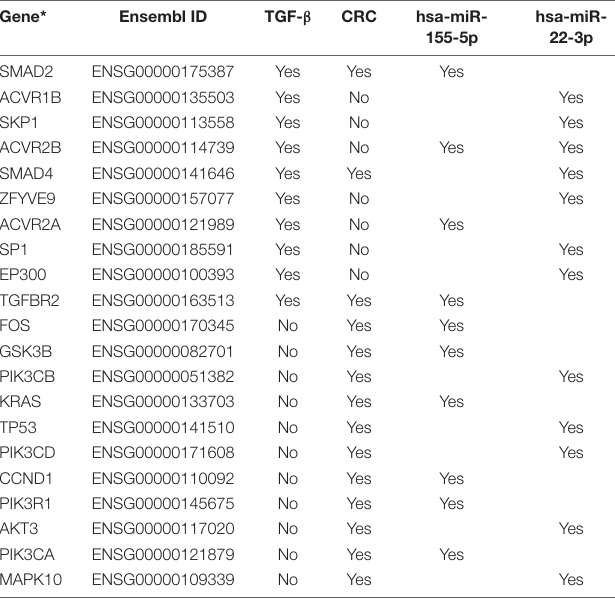
*MiRNA associated with microsatellite instability status, somatic tumor mutation burden, PD-L1 expression, M1 macrophage polarization that interact with the TGF- β signaling pathway (p = 0.008) and CRC pathways (p = 0.0001). Most of these genes interact with 2 miRNA sequences: hsa-miR-155-5p (p = 0.004)